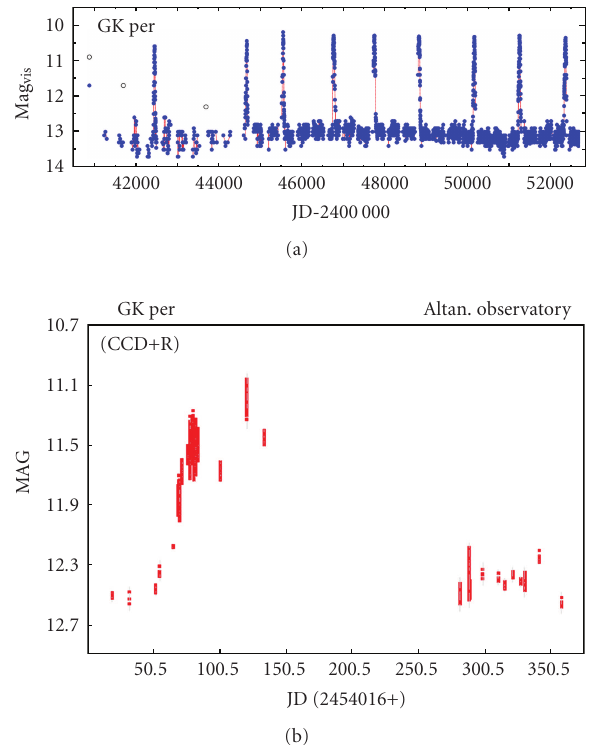
Figure 6: The long-term light curve of intermediate polar and INTEGRAL source GK Persei (top, source AAVSO) and the recent optical outburst in 2006 (bottom, according to Brat et al. 2006 [4]). The 2006 outburst appeared only 755 days from last outburst. For previous outbursts in 1992, 1996, 1999, 2002, and 2004, the separation was between 1091 and 1333 days, but before that the outburst separation was roughly N × 400 d, N = 1,2,3 [5].